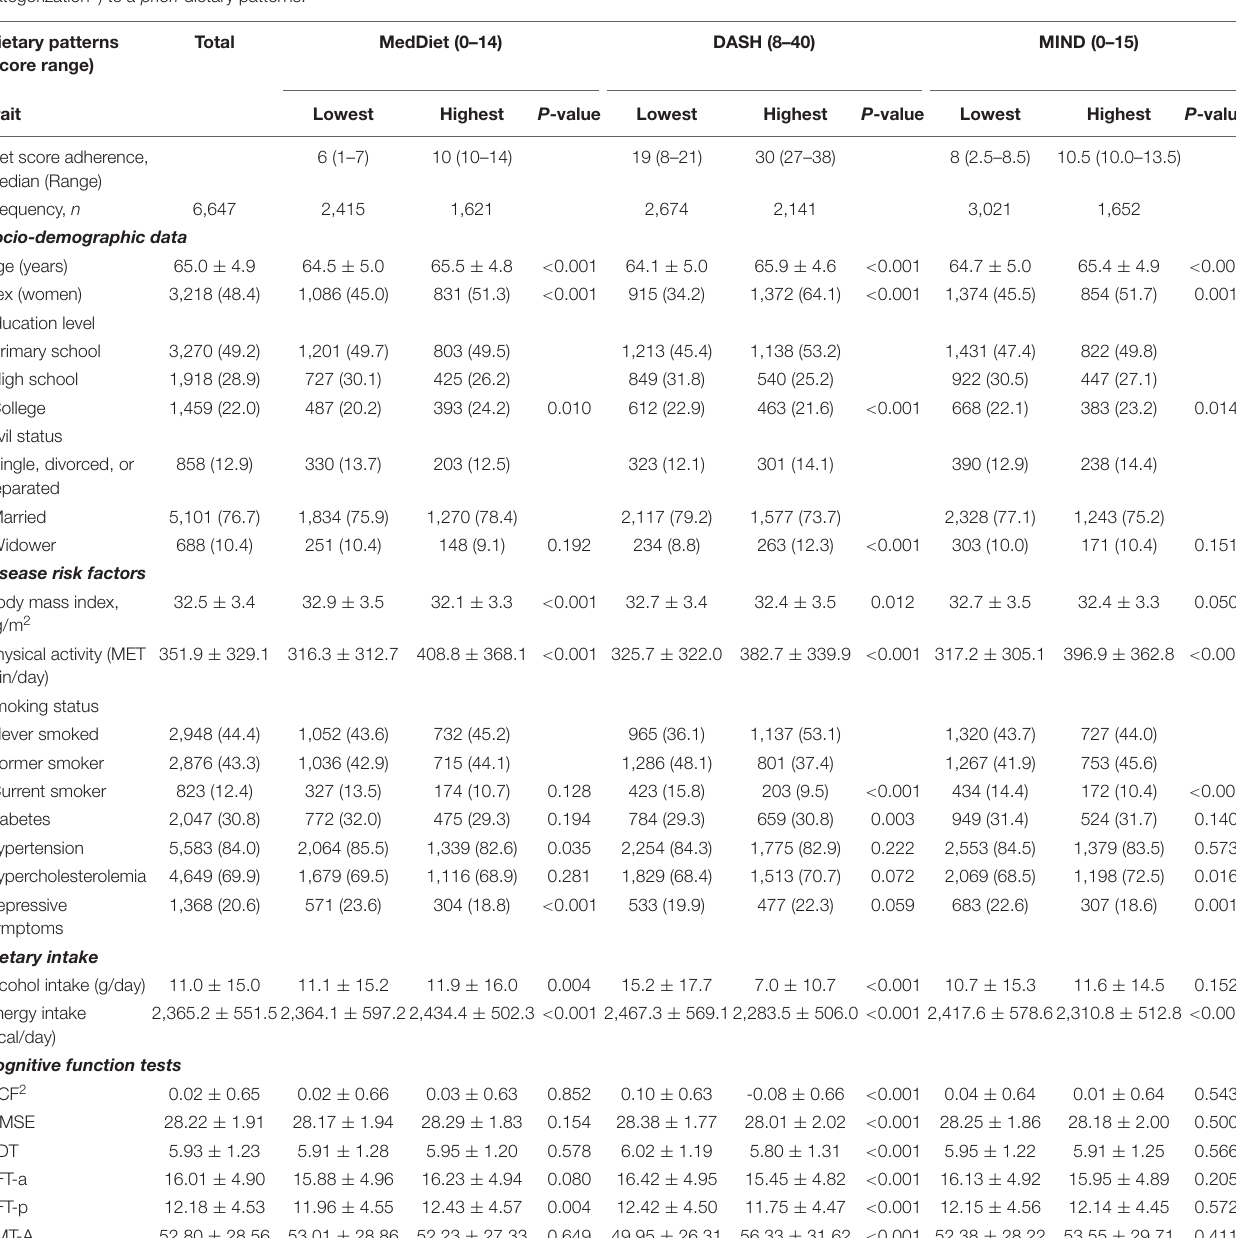
TABLE 1 | Baseline characteristics of the PREDIMED-Plus participants according to categories of highest and lowest baseline adherence (based on tertile categorization 1 ) to a priori dietary patterns. Dietary patterns (score